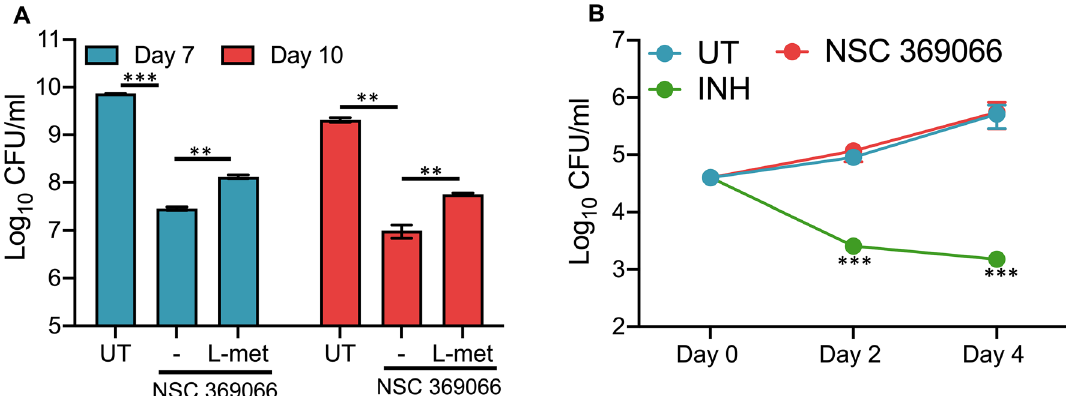
Figure 8. Activity of NSC369066 against M. tuberculosis in liquid cultures in the presence of L-methionine and in macrophages. ( A ) The cultures of M. tuberculosis were exposed to 5 × MIC 99 NSC369066 in the presence or absence of 250 µg/ml L-methionine and bacterial numbers were determined at day 7 and 10 post-exposure. The data shown in this panel in mean ± S.E. of log 10 CFU obtained from two experiments performed in duplicates. Statistical differences were observed for the indicated groups, paired (two-tailed) t-test, ** P < 0.01, *** P < 0.001. ( B ) Intracellular M. tuberculosis growth at 48 h and 96 h after treatment of THP-1 macrophages with INH or NSC369066 at 10 µM and 12.5 µM, respectively. The data shown in this panel in mean ± S.E. of log 10 CFU obtained from three independent experiments performed in duplicates. Statistical differences were observed for the indicated groups, One-way ANOVA using Dunnett method *** P <